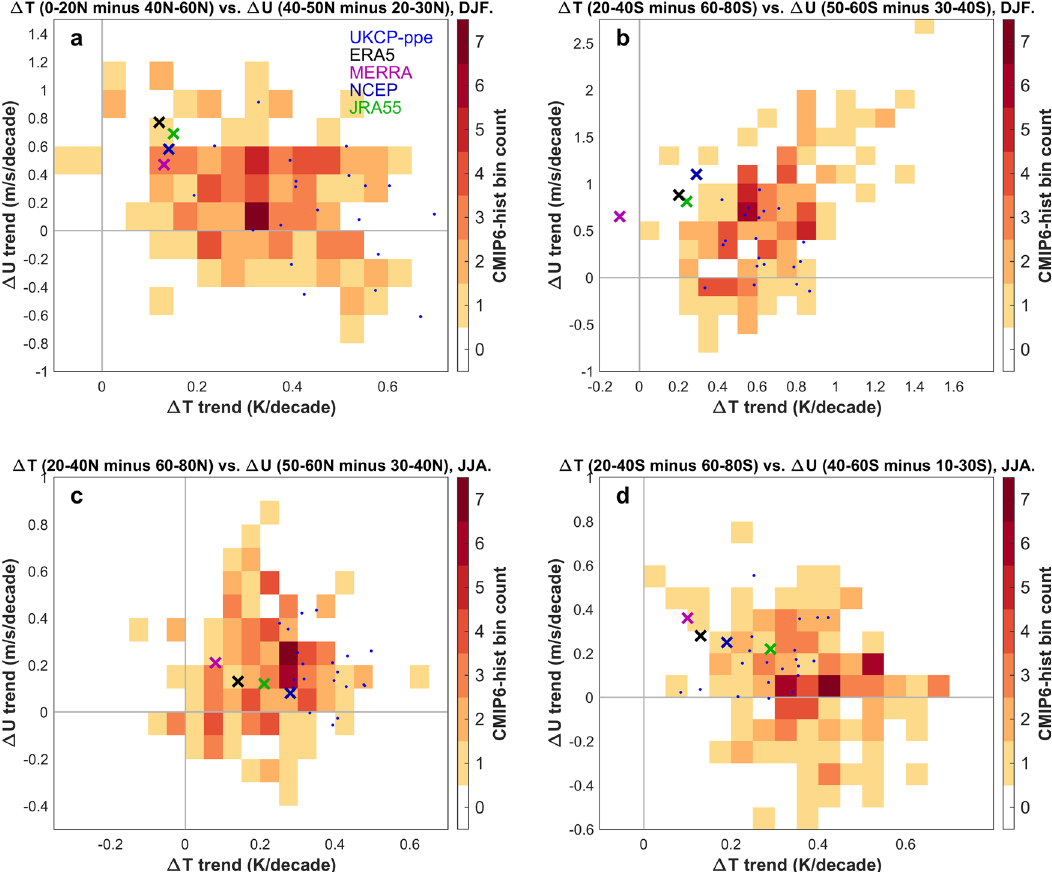
Fig. 3 Trends in 500hPa zonal wind indices plotted against the trends in 250hPa meridional temperature gradient. ( a ) Northern hemisphere DJF; ( b ) Southern hemisphere DJF; ( c ) Northern hemisphere JJA; ( d ) Southern hemisphere JJA. The zonal wind indices are calculated by subtracting the mean zonal wind at high latitudes from the wind at low latitudes. In contrast the meridional temperature gradients are presented as low minus high latitude mean temperatures. Crosses mark the reanalysis trends, dots mark the UKCP-PPE20 ensemble members and the squares indicate the occurrence of trends in the CMIP6 ensemble. Trends were taken over 1979-2019 for the reanalyses and UKCP-PPE20, and over 1979 – 2014 for